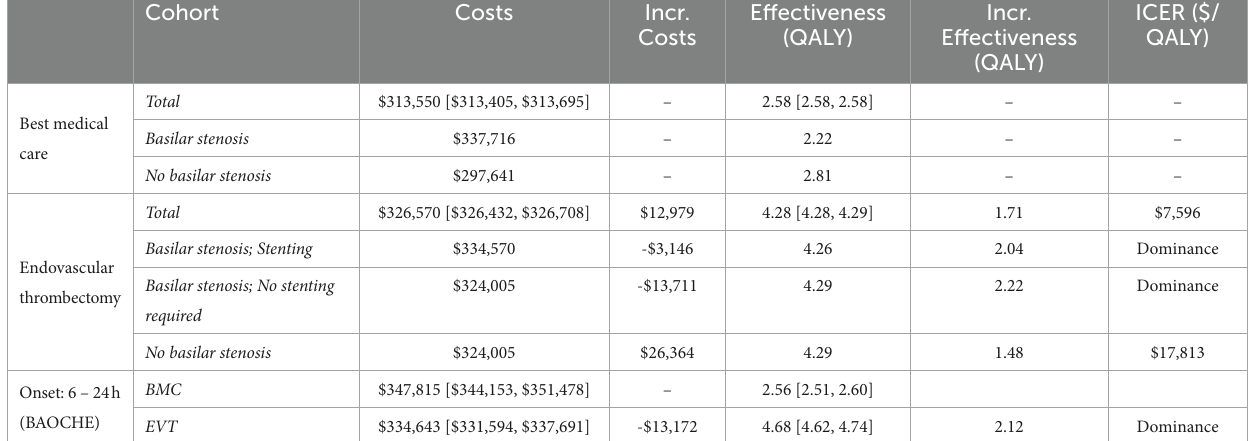
TABLE 3 Cost-effectiveness